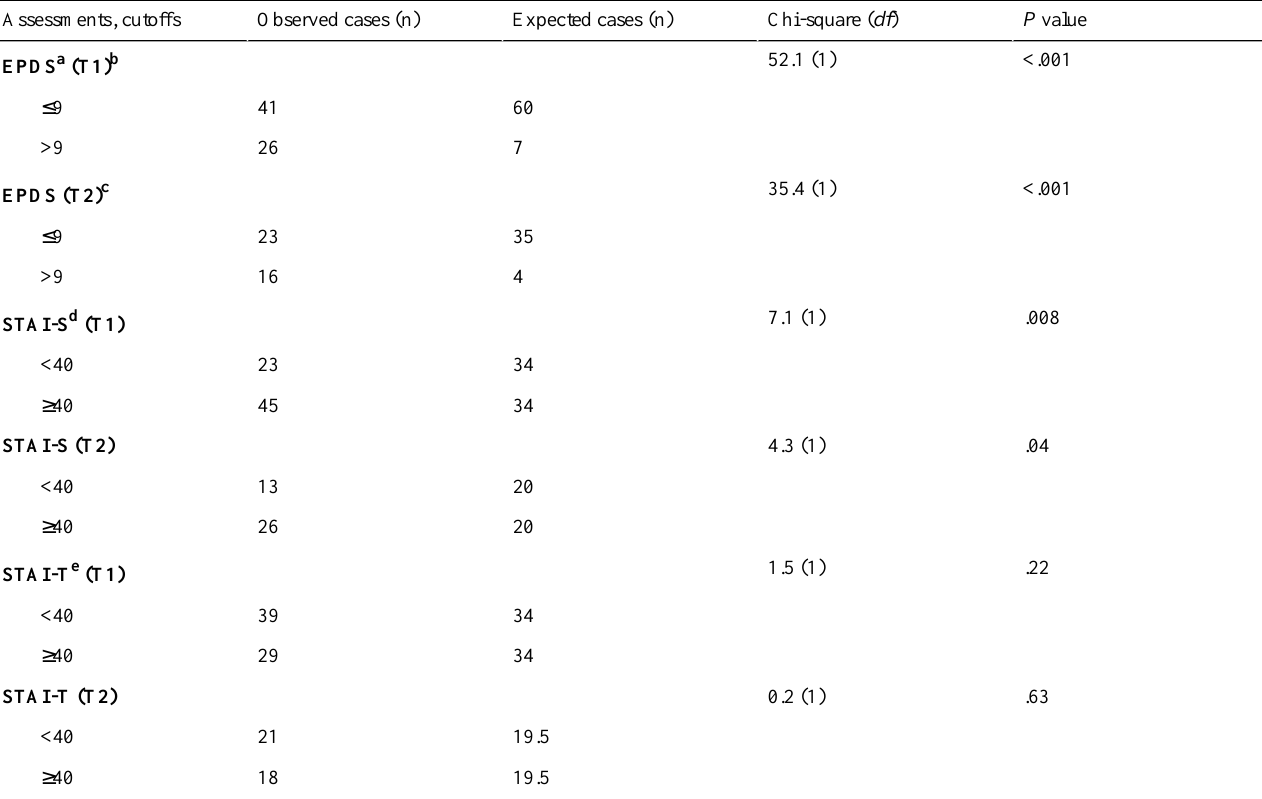
Table 6. Chi-square tests on the distribution of the cases below and above the